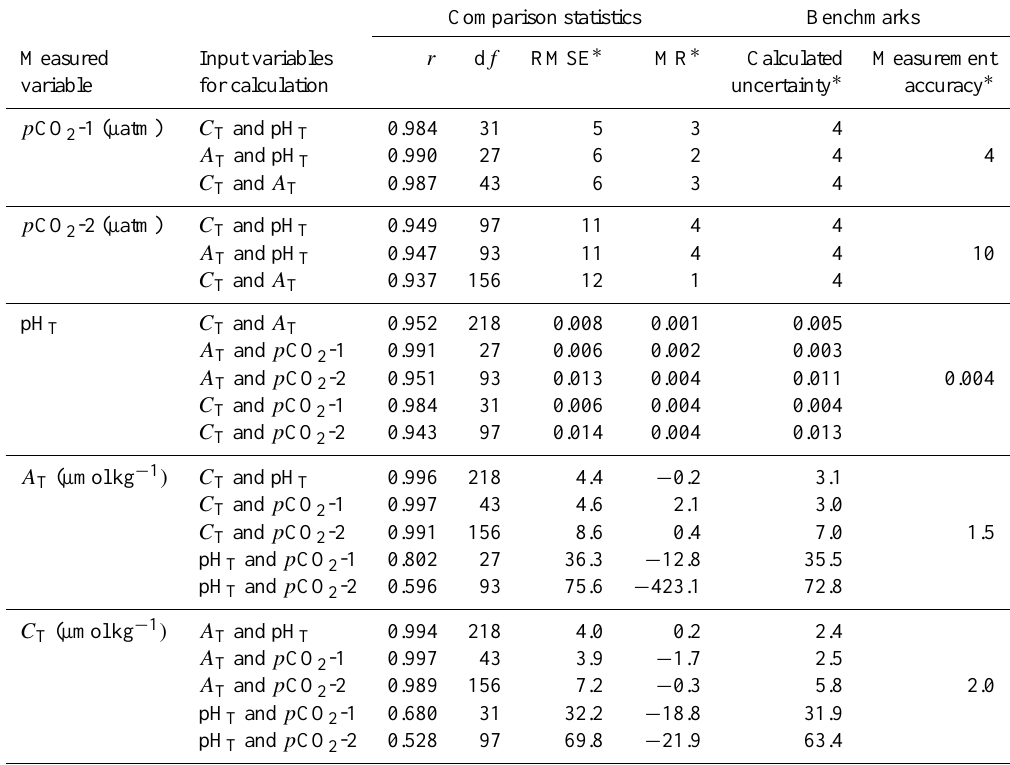
Table 1. Results of comparisons between direct measurements and values calculated (using the CO2SYS software) from measurements of other variables. r is Pearson’s correlation coefficient, df is degrees of freedom, RMSE is root mean square error and MR is mean of the residuals. The measurement accuracy is from Sect. 2.1. Note that calculated p CO 2 -1 and calculated p CO 2 -2 have the same uncertainty because they depend only on the accuracies of the variables from which they are calculated. They are therefore identical for both p CO 2 systems. Calculated uncertainty of parameters calculated using p CO 2 -2 as an input variable is higher than those using p CO 2 -1, because the measurement accuracy is